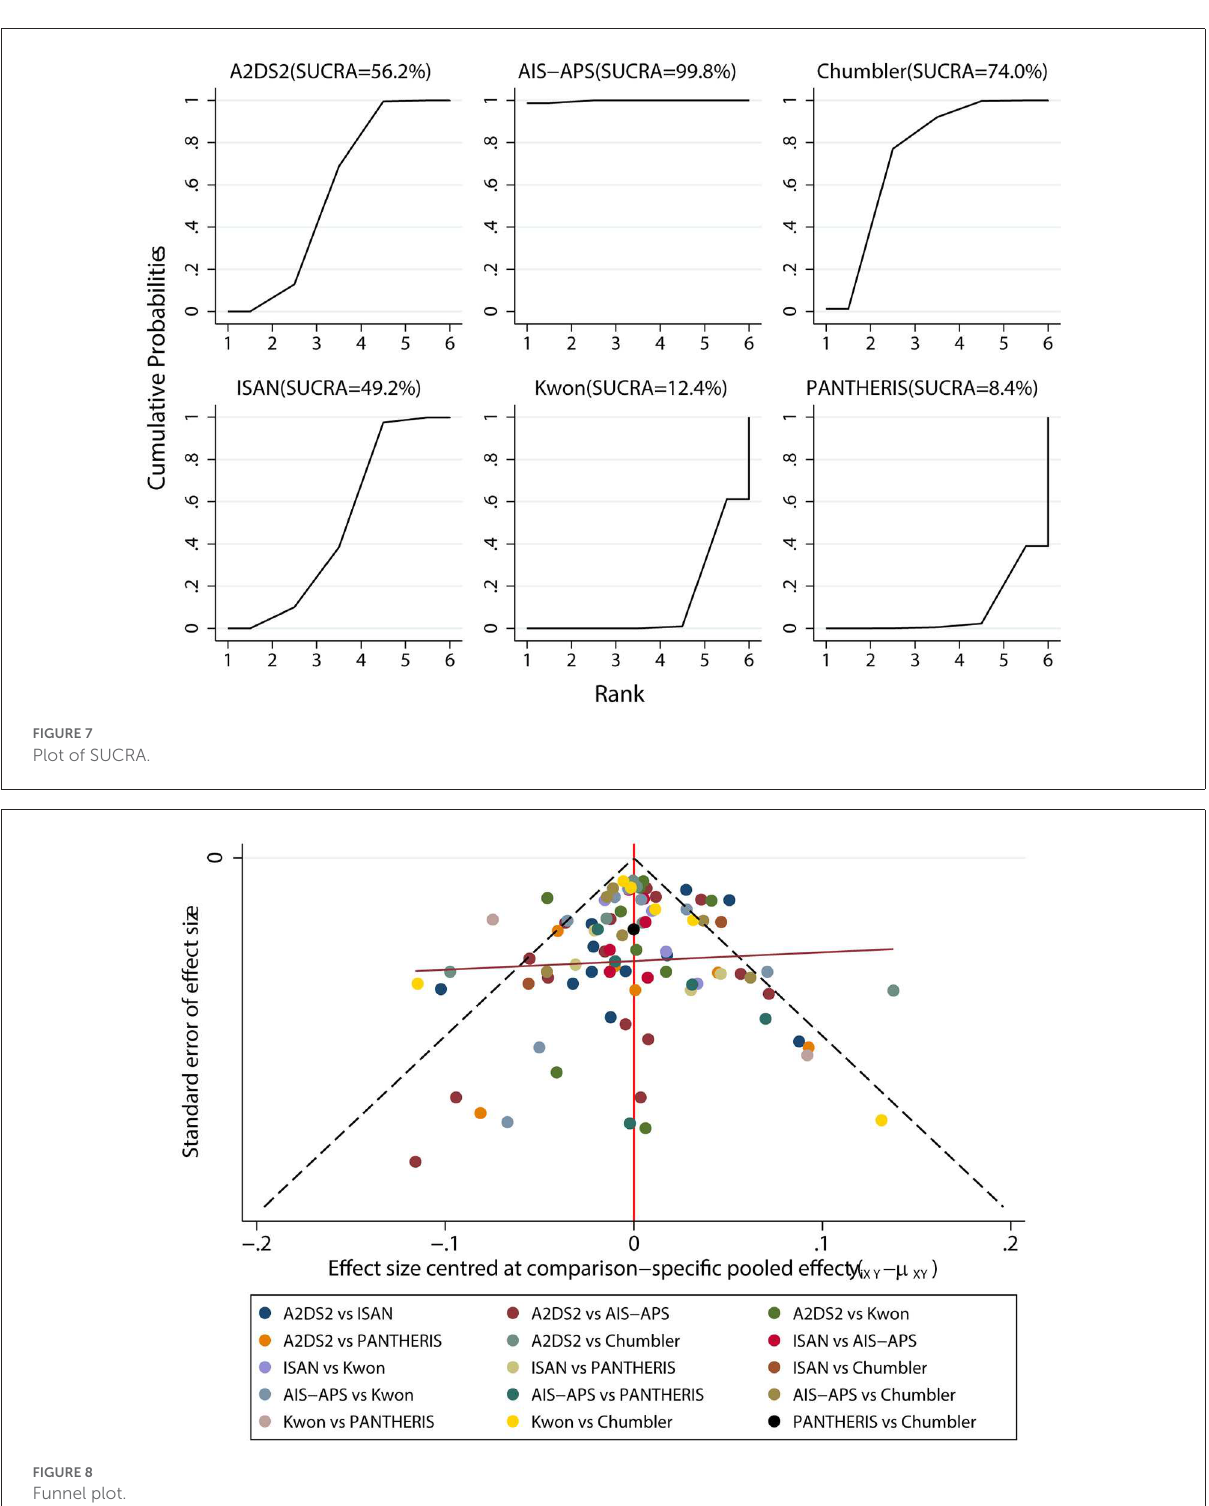
preventive antibiotics in patients with stroke. In addition, except preventive antibiotics, lots of other intervention could prevent SAP in patients with stroke of high risk. For instance, dysphagia